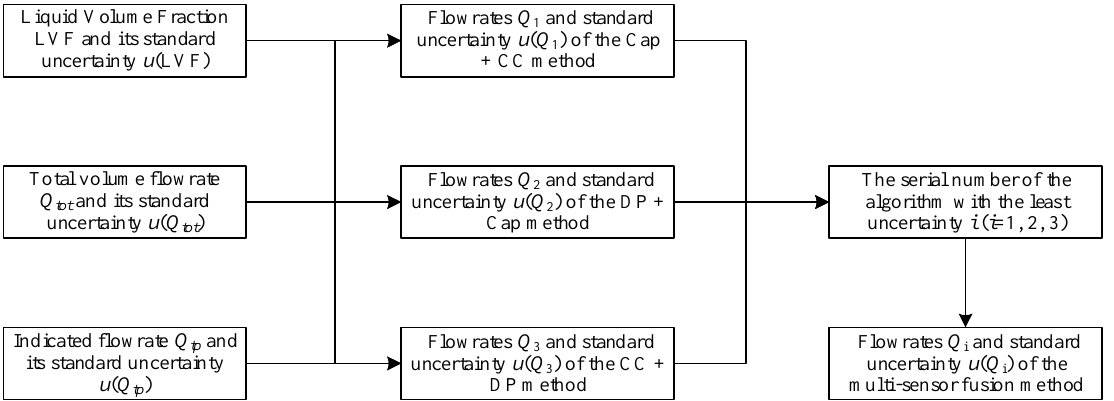
Figure 19. The calculation procedures of the multi ‐ sensor fusion algorithm.